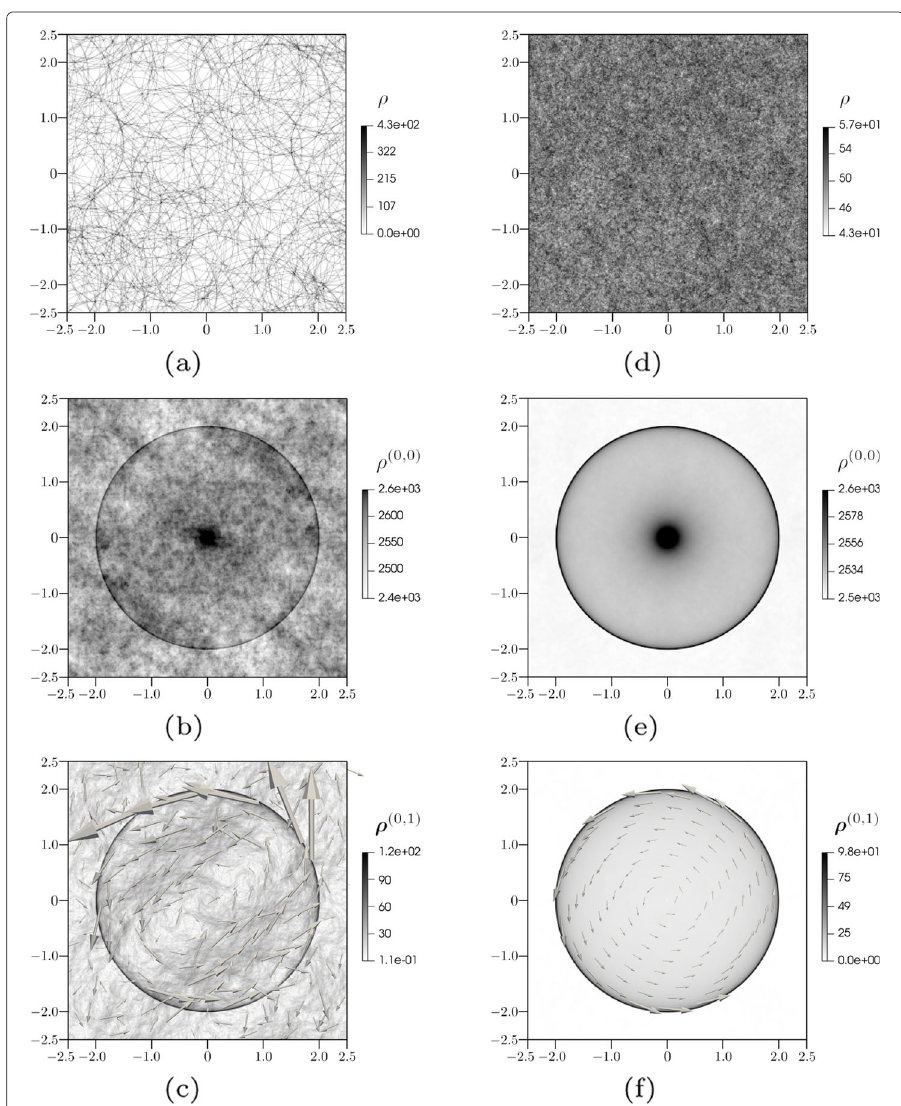
Fig. 10 Density ρ , scalar pair density ρ ( 0,0 ) and vector pair density ρ ( 0,1 ) of a single realization ( a to c ) and of 1000 realizations ( d to f ) of a distribution of 200 loops with random center points and radius R = 1